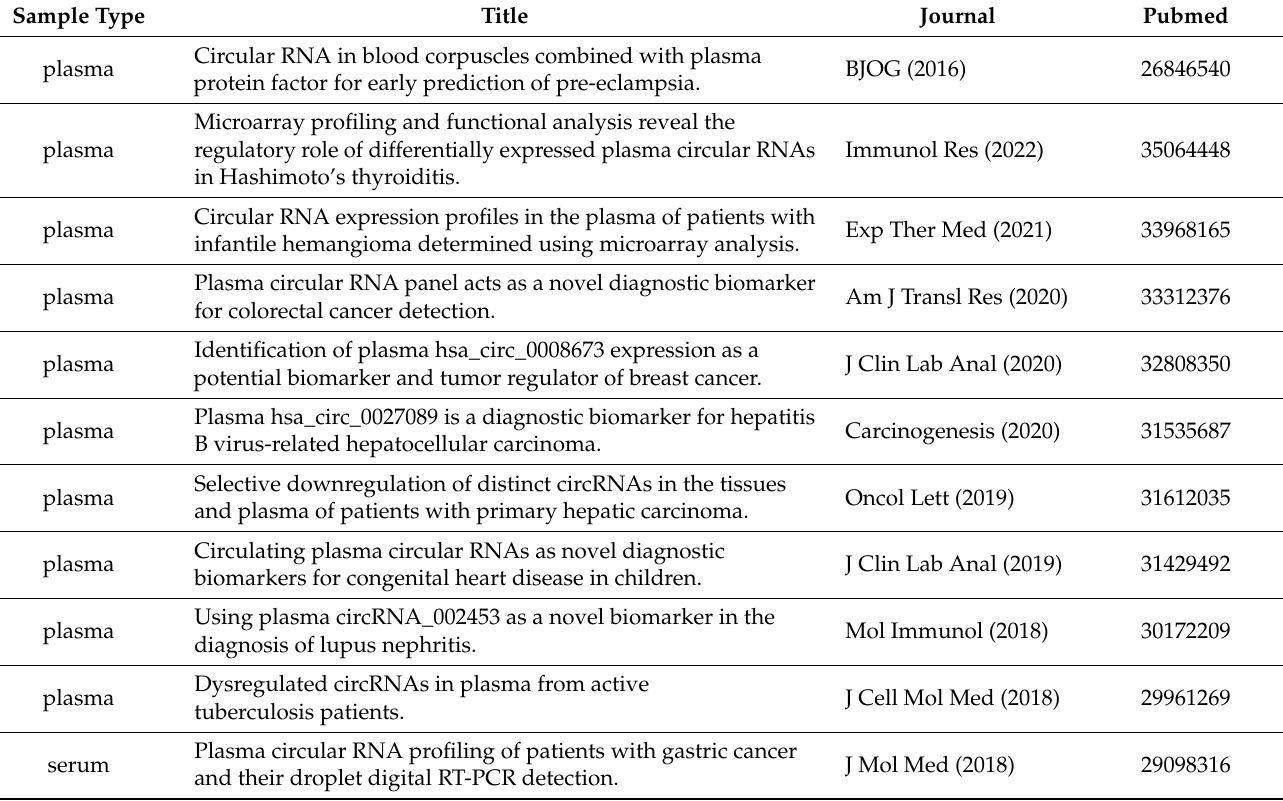
Table 5. Published biofluid biomarker studies based on circRNA microarray